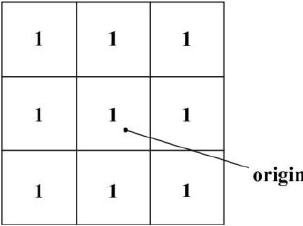
Figure 7. A square structure element with size of 3 ×